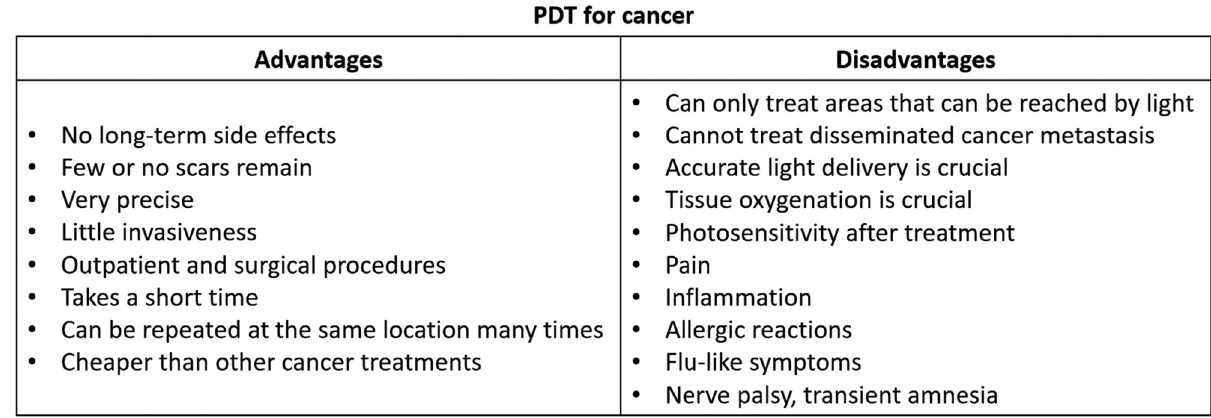
Figure 3: Advantages and disadvantages of antitumor